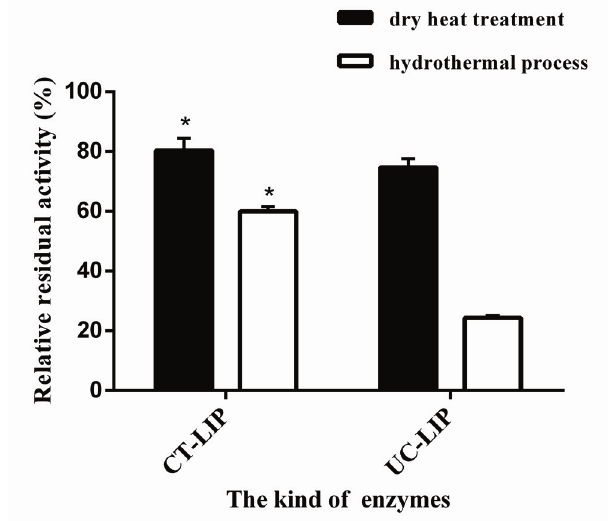
Figure 3. Comparative effects of dry heat treatment and hydrothermal process on the lipase relative residual activity of coated lipase (CT-LIP) and uncoated lipase (UC- LIP). Data were presented with mean±standard deviation (n = 6). Vertical error bars show standard deviation of measured relative activity (*